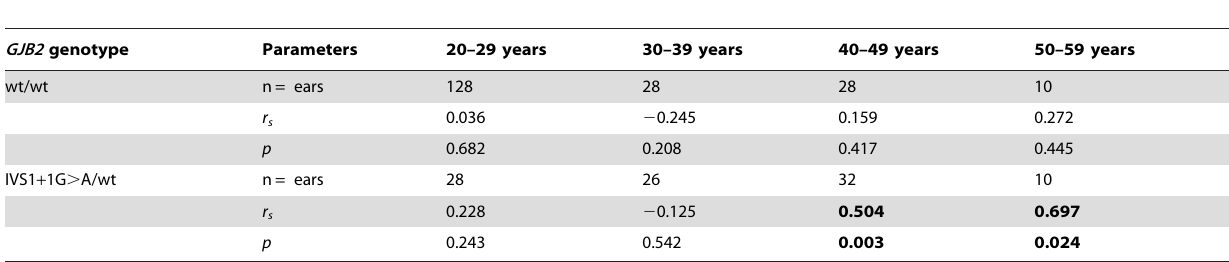
Table 2. Correlation of increase of hearing thresholds in PTA 0.5,1.0,2.0,4.0 kHz according to age in individuals with GJB2 genotype wt/ wt and IVS1 + 1G . A/wt.